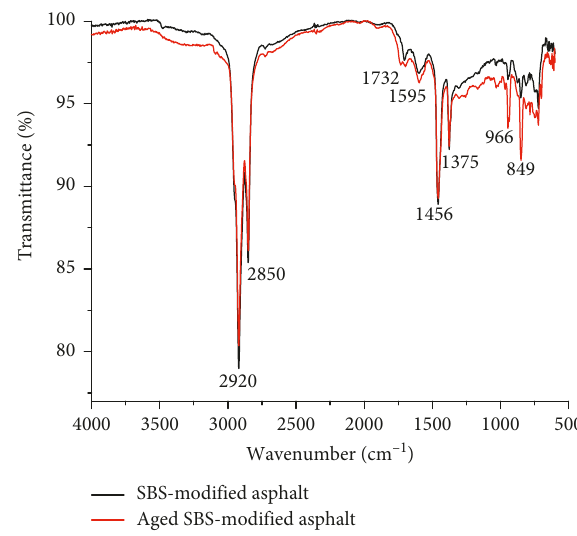
Figure 14: FTIR spectra of original and aged SBS-modified asphalt.